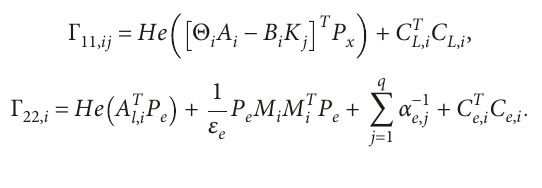
Table 1: Nonlinear system